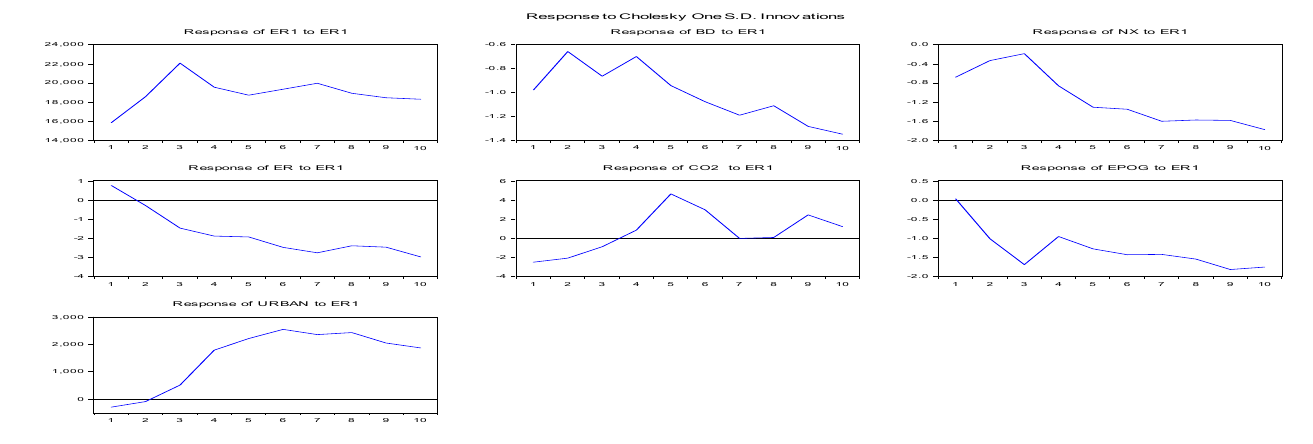
Figure 3. Impulse response (Model 2).